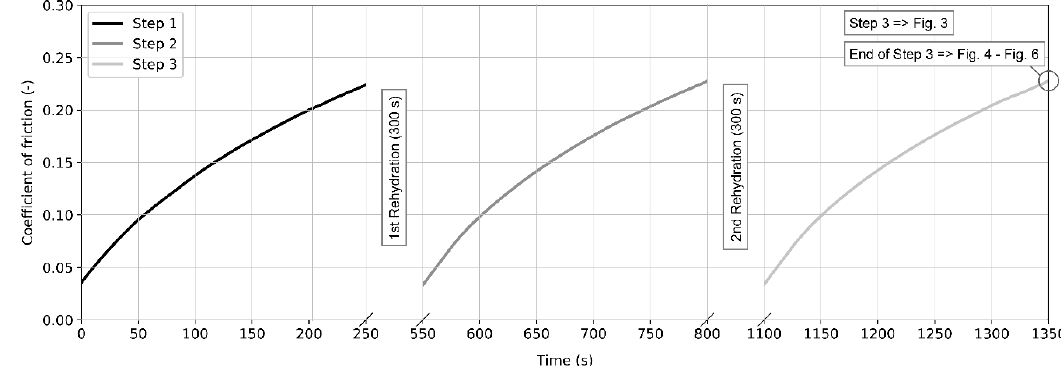
Figure 2. A schematic illustration of the test procedure.